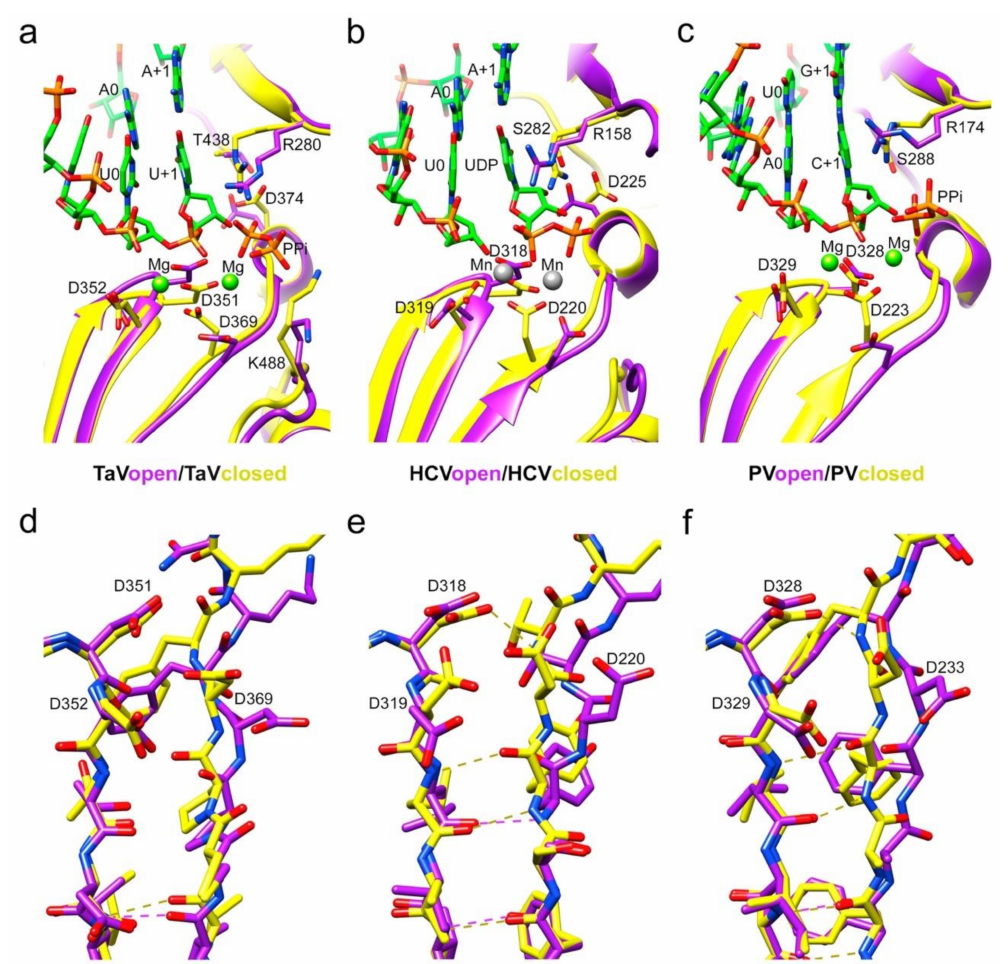
Figure 3. Local rearrangements of the TaV pol active site on substrate binding. Comparison with the open and closed active site conformations in Flavivirus and Picornavirus RdRPs. ( a ) Ribbon representation of the TaV pol , apo form, showing an open conformation of the active site (magenta) compared with the TaV pol ∆ 607-624/5 (cid:48) CAAAAUUU3 (cid:48) complex after UMP incorporation (closed conformation; yellow). Only the base pair A+1:U+1, A0:U0 and A-1:U-1 are shown in the stick representation in the atom type color: C green, P orange, O red and N blue. The pyrophosphate byproduct (PPi), present in the catalytic site, is also shown as sticks. The two Mg+2 ions present in the active site of the TaV pol ∆ 607- 624/5 (cid:48) CAAAAUUU3 (cid:48) complex are shown as green spheres. Changes in the main chain conformation and reorientation of side chains of residues: D351 (active site; motif C), D369 (active site; motif A) and D374 (NTP 2 (cid:48) OH recognition; motif A) and K448 (general acid; motif D) are apparent. ( b ) Ribbon representation of the HCV RdRP (closed, PDB id 4WTA, yellow) in complex with a template/primer RNA. Only the base A+1 and A0 in the template and U0 in the primer are shown as sticks as in A. The incoming UDP substrate (atom type sticks), base paired with A+1 and the two Mn2+ ions (grey spheres) are also shown and explicitly labeled. The HCV open conformation (purple) corresponds to the apo enzyme (PDB id: 2XI2). The side chains of the RNA-interacting residues in the catalytic site, motifs A to D, are shown as sticks and explicitly labeled. ( c ) Ribbon representation of PV the RdRP (PV closed, PDB id: 3OPL7, yellow) in complex with a template/primer/product RNA (with the base pairs G+1:C+1 and A0:U0 shown and explicitly labeled), and two Mg 2+ ions (green spheres). The PPi byproduct is also shown as sticks. PV open (yellow) corresponds to a PV RdRP–RNA complex after reaction and translocation (PDB id: 3OL6). Panels d to f show stick representations of the superimpositions of the β -strands containing motifs C and A in TaV pol ( d ), HCV ( e ) and PV ( f ), with the main chain hydrogen bonds indicated in dashed lines and the side chains of the catalytic aspartic acid residues explicitly